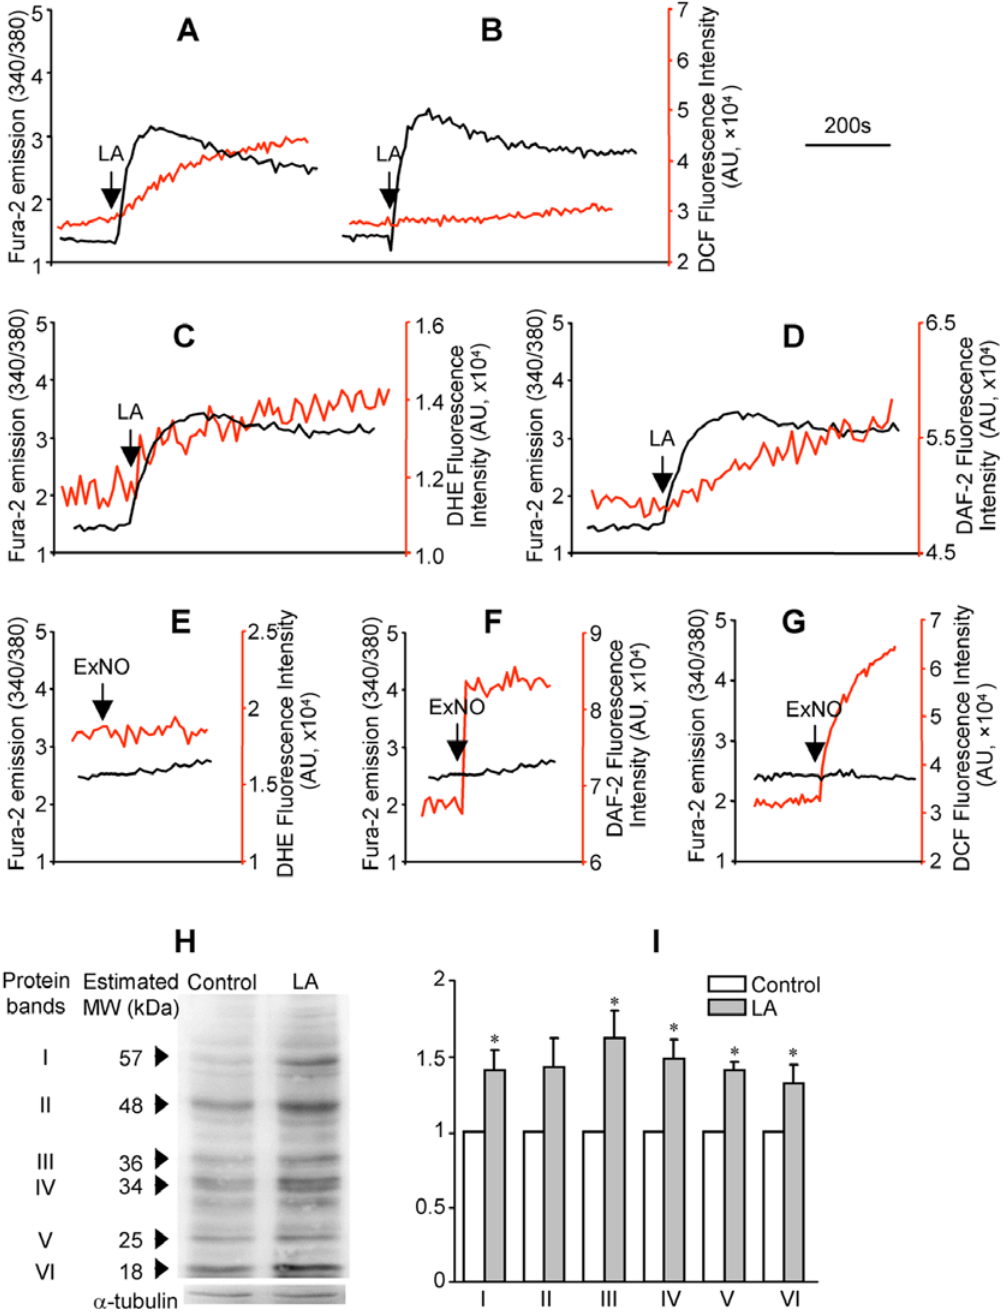
Figure 2. The LA-induced ROS signal was identified as peroxynitrite. (A): HM cells were labeled with fura-2 and DCF and traces represent LA- induced [Ca 2 + ] i mobilization (black trace) and ROS generation (red trace); (B): same measurements performed in cells treated with FeTPPS (a specific peroxynitrite decomposer; 0.5 m M, 30 min) prior to LA addition and the treatment inhibited the ROS signal significantly; (C) and (E): HM cells were labeled with fura-2 and dihydroethidium (DHE, 1 m M) and traces represent LA (C) or S-nitroso-N-acetylpenilillamine (exogenous NO donor, ExNO, 50 m M; E) responsive [Ca 2 + ] i mobilization (black trace) and superoxide generation (red trace); (D) and (F): HM cells were labeled with fura-2 and 4,5- diaminofluorescein diacetate (DAF-2, 0.5 nM) and traces represent LA (D) or ExNO (F) responsive [Ca 2 + ] i mobilization (black trace) and NO generation (red trace); (G) HM cells were labeled with fura-2 and DCF and traces represent ExNO responses in [Ca 2 + ] i (black trace) and peroxynitrite (red trace). The nitrotyrosine level in the cellular proteins was determined by western blot analysis in vehicle-(control) or LA-treated HM cells using a -tubulin as the loading control. The image (H) shows a representative experiment. The graphs (I) represent the mean ratio value 6 SEM of the density of protein band over a -tubulin. * P , 0.05, n=4, LA vs control.